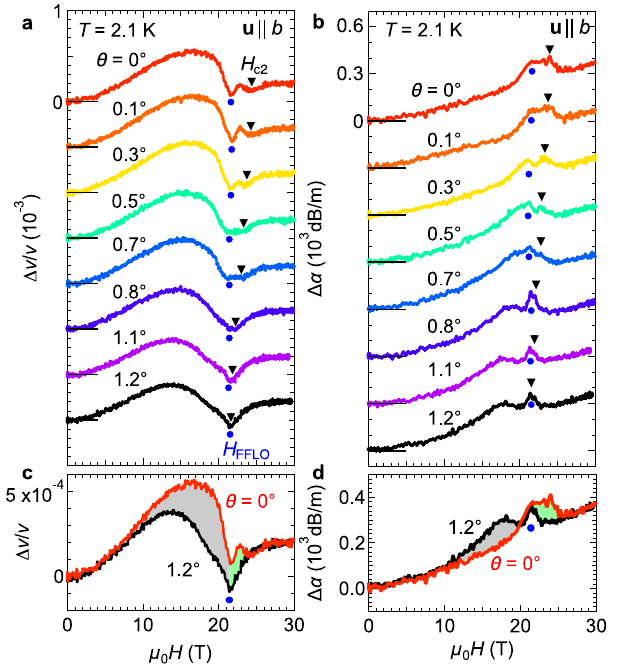
Fig. 2 | Low-temperature and high- fi eld ultrasonic properties when θ ~0°. a , b Magnetic fi eld dependence of Δ v / v a and Δ α b at 2.1K. The blue and black symbols indicate the dips in Δ v / v and the peaks in Δ α . The black line represents offset for each dataset. c , d Enlarged plot of the datasets at 0° and 1.2°. The green area indicates the difference between the 0° and 1.2° data, which re fl ects the contribution of the FFLO state.